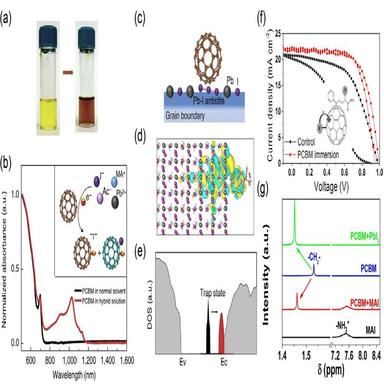
(a) Pristine perovskite solution (left) and PCBM-perovskite hybrid solution (right). (b) UV–Vis absorption spectra of the hybrid solution shows the interaction between PCBM and perovskite ions. (c) Schematic of in situ PCBM passivating halide-induced deep trap. Wavefunction overlap (d) and DFT calculation of density of DOS (e) for PCBM on defective perovskite surface. Copyright 2015, Springer Nature Limited. (f) J-V curves of PSCs without and with PCBM. (g) Nuclear Magnetic Resonance (NMR) sp